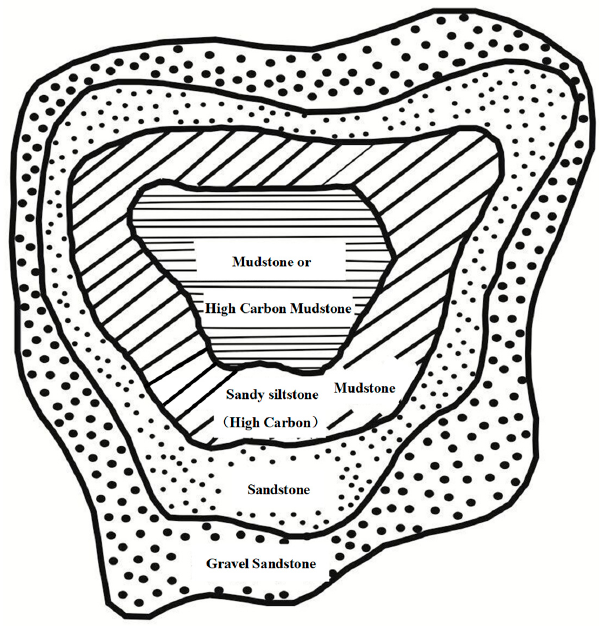
Figure 3. Typical red-bed sedimentary model in South China.